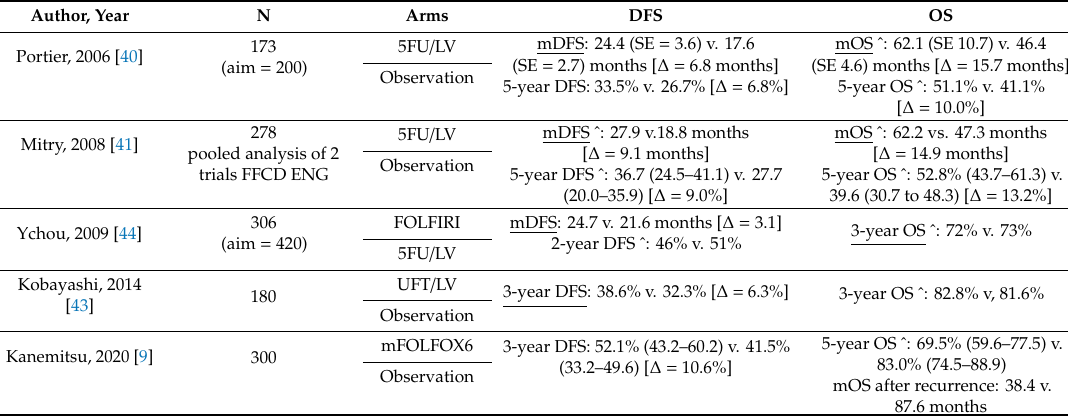
Table 3. Adjuvant chemotherapy for resected disease. DFS, disease-free